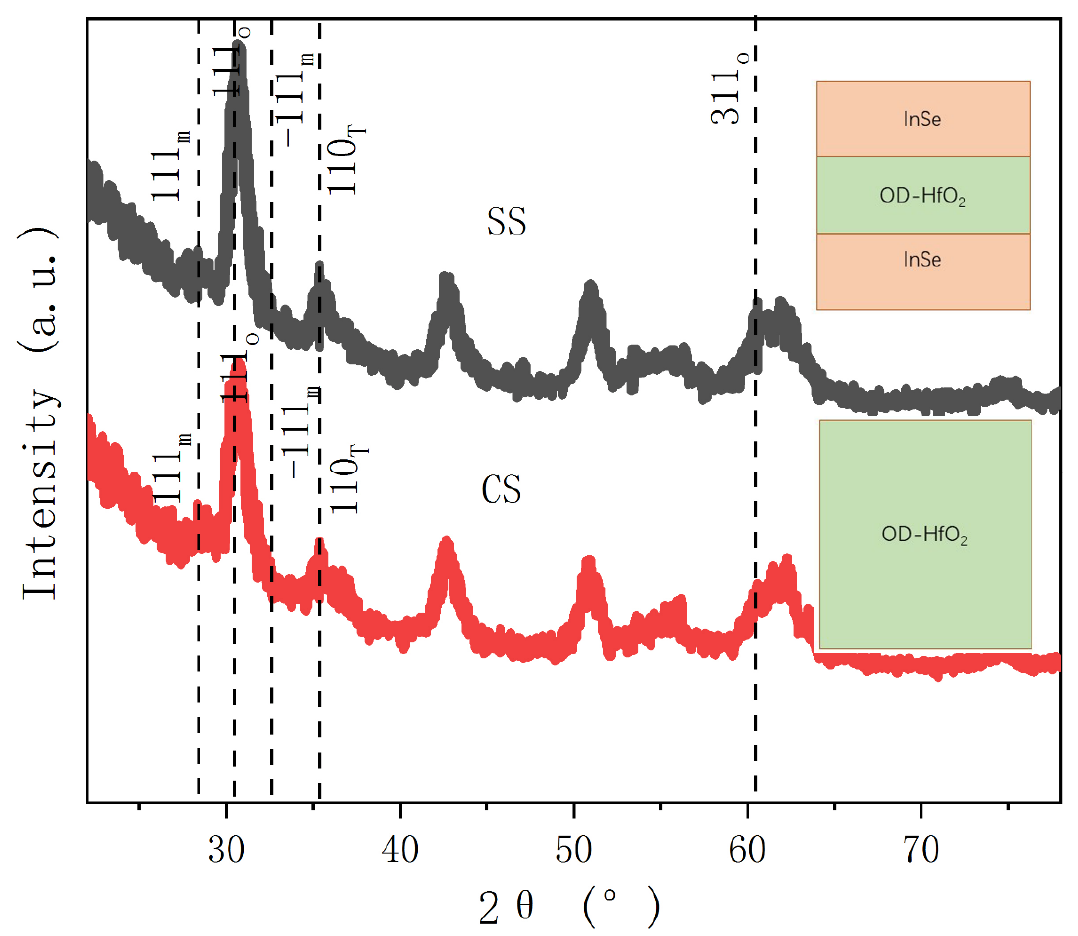
Figure 3. GIXRD patterns of SS and CS samples. Peaks in the range of 23°–34° correspond to the ferroelectric phase, the o-phase. The proportion of the o-phase is larger for SS compared to the CS sample.